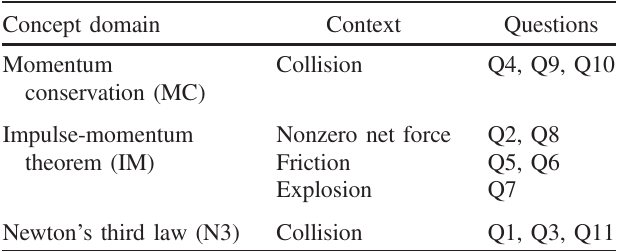
TABLE I. Assessment items used in this